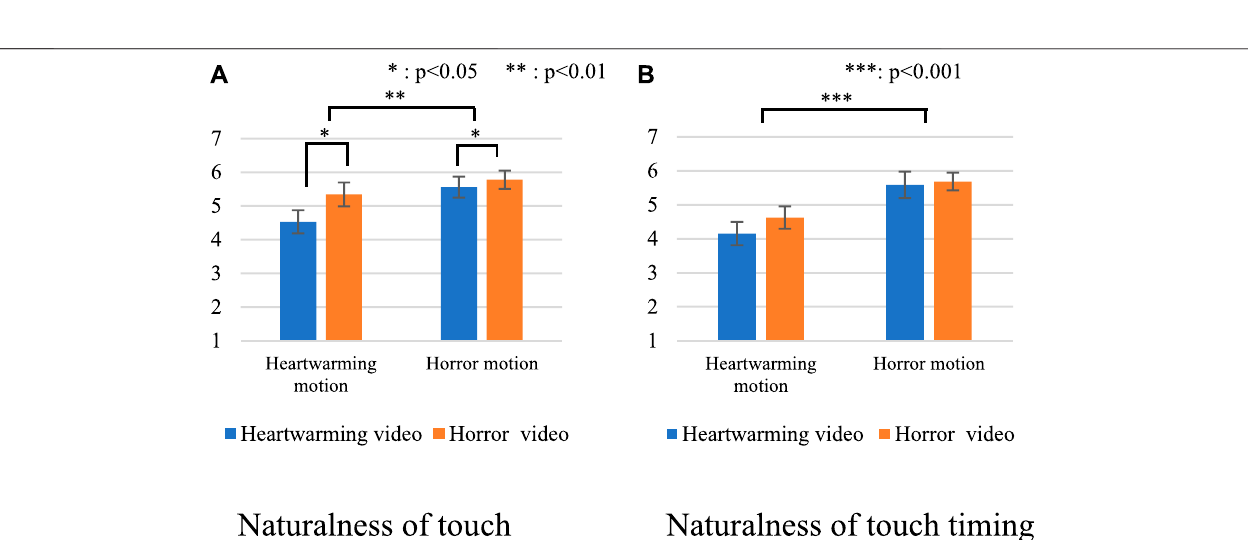
Frontiers in Robotics and AI |